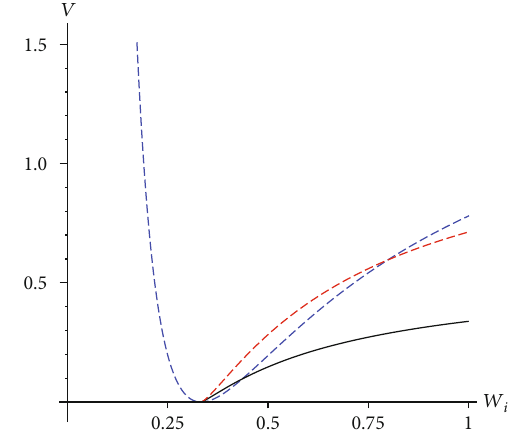
Figure 2: The relation between the government ’ s strategies u the weight parameter w i .